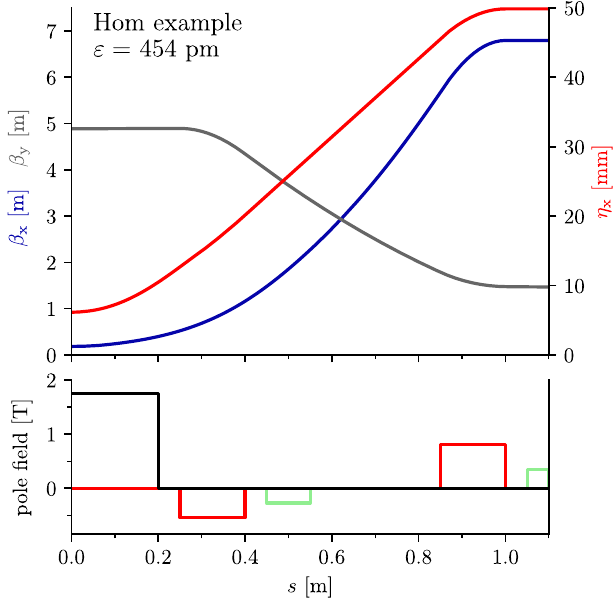
FIG. 4. Half cell with a homogeneous bend. The upper plot shows the optical functions β (blue), β (gray) and dispersion η x y x (red). The lower plot shows the pole-tip field components for R ¼ 13 mm half gap (or bore radius): dipole ( B , black), quadru- pole ( B 0 R , red), and sextupole ( B 00 R 2 = 2 ,